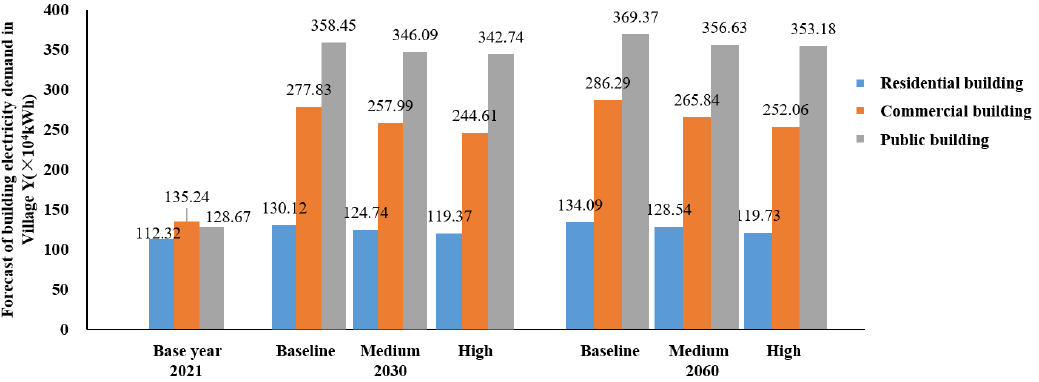
Figure 3. Forecast of building electricity demand in village Y from 2021 to 2060.